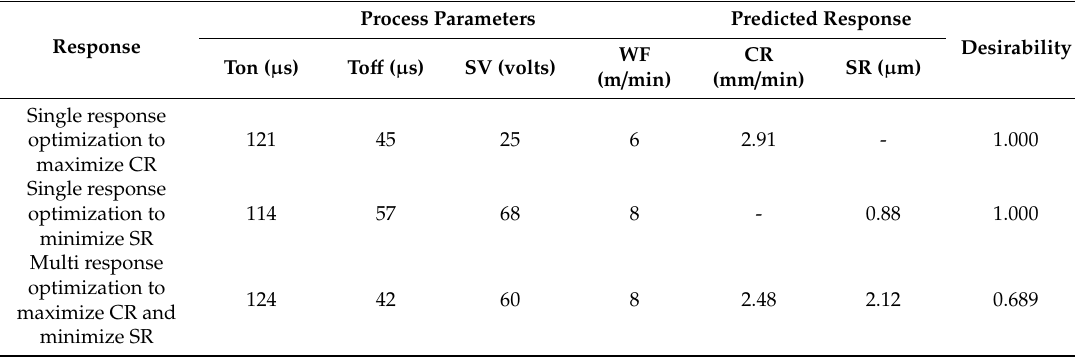
Table 8. Single and multi-objective optimization for desirability at high